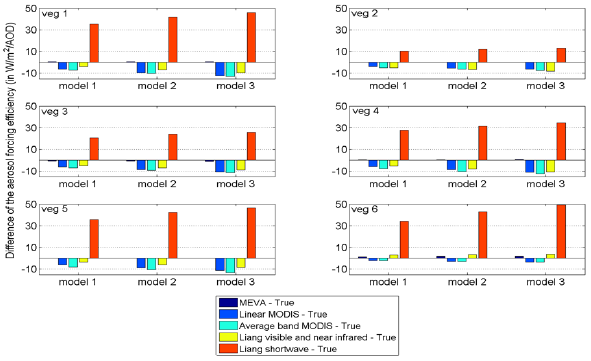
Fig. 11. Difference of the aerosol forcing efficiency (in Wm − 2 AOD − 1 ) associated with different approaches to estimate reflectance spectra for vegetation types shown in Fig. 9. In each subplot, three groups indicate the results caused by using three dif- ferent aerosol models shown in Fig. 10: SSA (at 0.55µm)=0.95 (noted as “model 1”), 0.89 (noted as “model 2”), and 0.83 (noted as “model 3”). Other parameters used in the calculations include AOD (at 0.55µm)=0.32 and SZA=30 degrees.